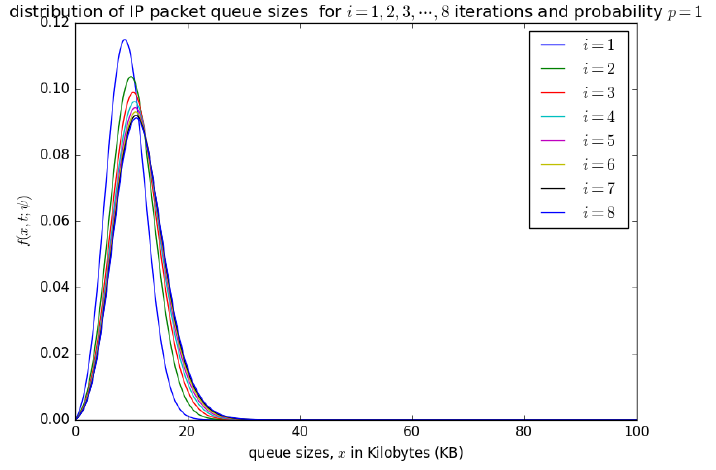
Figure 17. The distribution of the aggregation queue size, f ( x , t ; ψ ) if p = 1 for consecutive iterations as in Equation (18) i = 1 . . . 25.